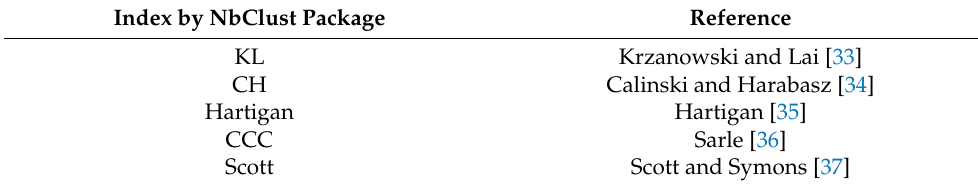
Figure 8. Results of k -means clustering on container ship deadweight tonnage–length overall (m). ( a ) Number of clusters selected by NbClust; ( b ) Hubert statistic values; ( c ) D index value; ( d ) scatter plot clustered into three groups. Table 3. K -means clustering indices using NbClust package in this